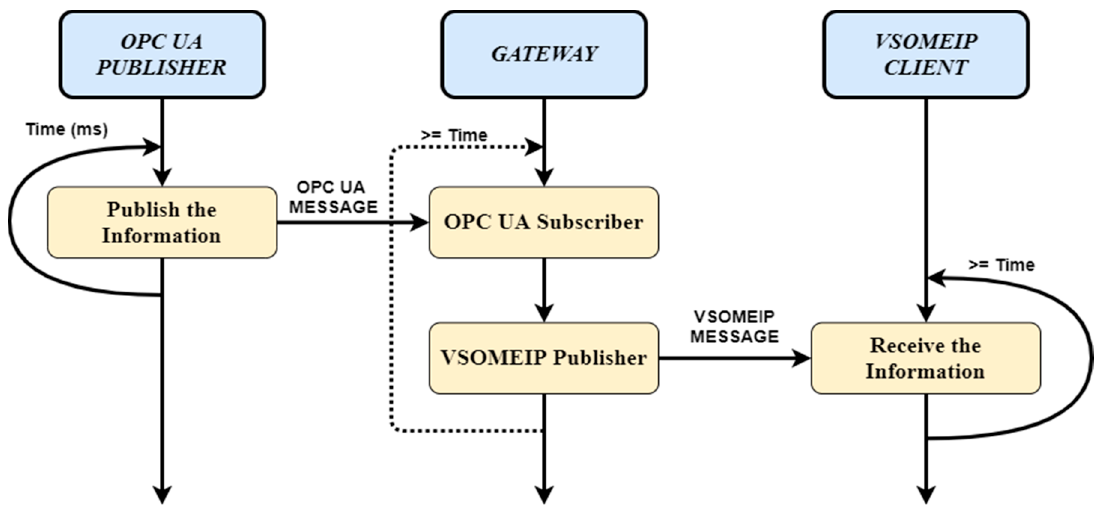
Figure 5. Dependency between Gateway application components, OPC UA and VSOME/IP in the Real-Time Publish-Subscribe context.